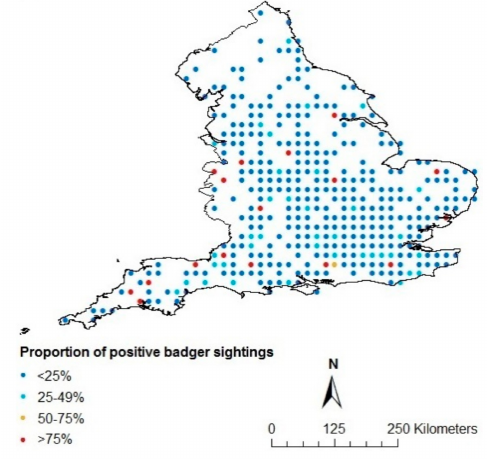
Figure 2. Proportion of positive badger sightings according to the ‘Living with Mammals’ survey of